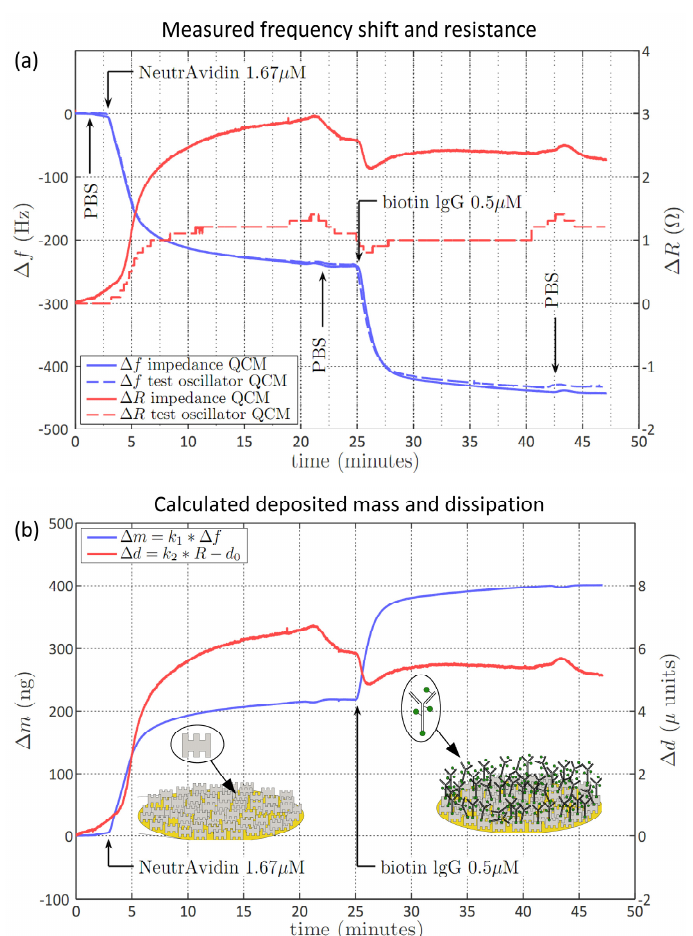
Figure 2. Impedance QCM measurement results of a simple bio-chemical test reaction. ( a ) The impedance QCM raw data (solid blue and red lines) is compared to the test oscillator QCM (dashed lines) (both with 9.995 MHz quartz crystals). Blue traces show frequency changes (Hz, left axis), and red traces show resistance changes (Ohm, right axis). After washing the liquid chamber with PBS (phosphate-buffered solution) the first step in this reaction is the adsorption of NeutrAvidin on gold (240 Hz shift) followed by the specific binding of biotin labeled antibodies (IgG, immunoglobulin G; 195 Hz shift); ( b ) based on the raw data the mass adsorption (ng; left axis) and the change in dissipation (micro-units; right axis) are calculated. The mass adsorption is inversely proportional to the frequency shift (k 1 ), while the dissipation is proportional (k 2 ) to the resistance. The sketches show the adsorption of avidin to the gold surface and the subsequent specific binding of biotin-IgG to the avidin